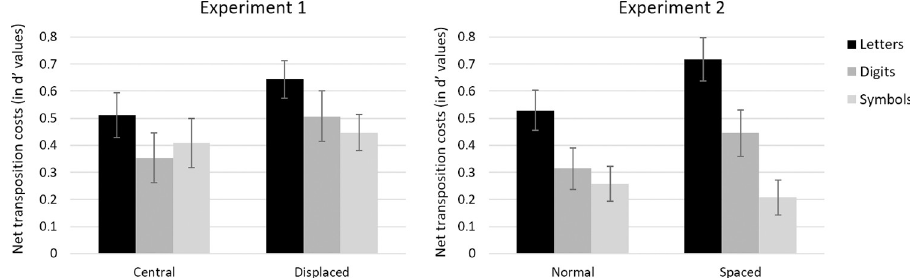
Fig 7. Net transposition costs (in d’ values) as a function of target displacement (Experiment 1, left panel) and inter-character spacing (Experiment 2, right panel) for the three types of stimuli. Error bars represent standard